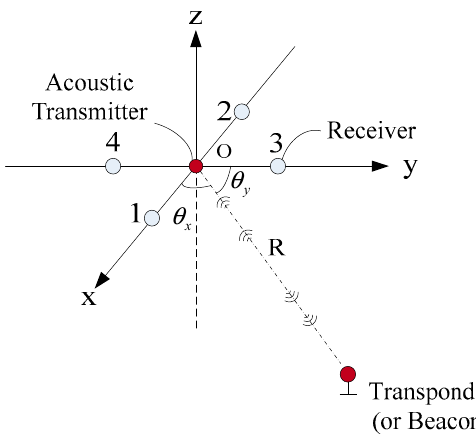
Figure 1. The schematic diagram of the Ultra-Short Base Line array structure based on four receiving array elements.